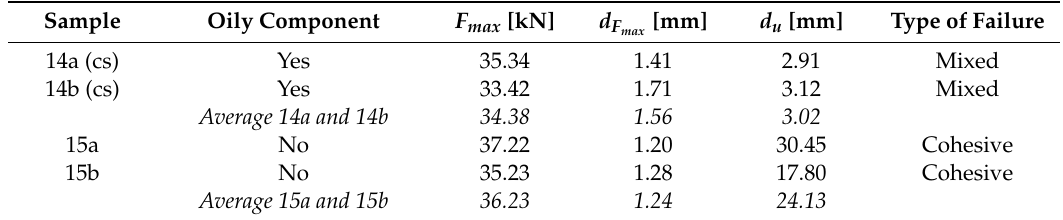
Table 5. Experimental results for samples 14a, 14b, 15a and 15b.